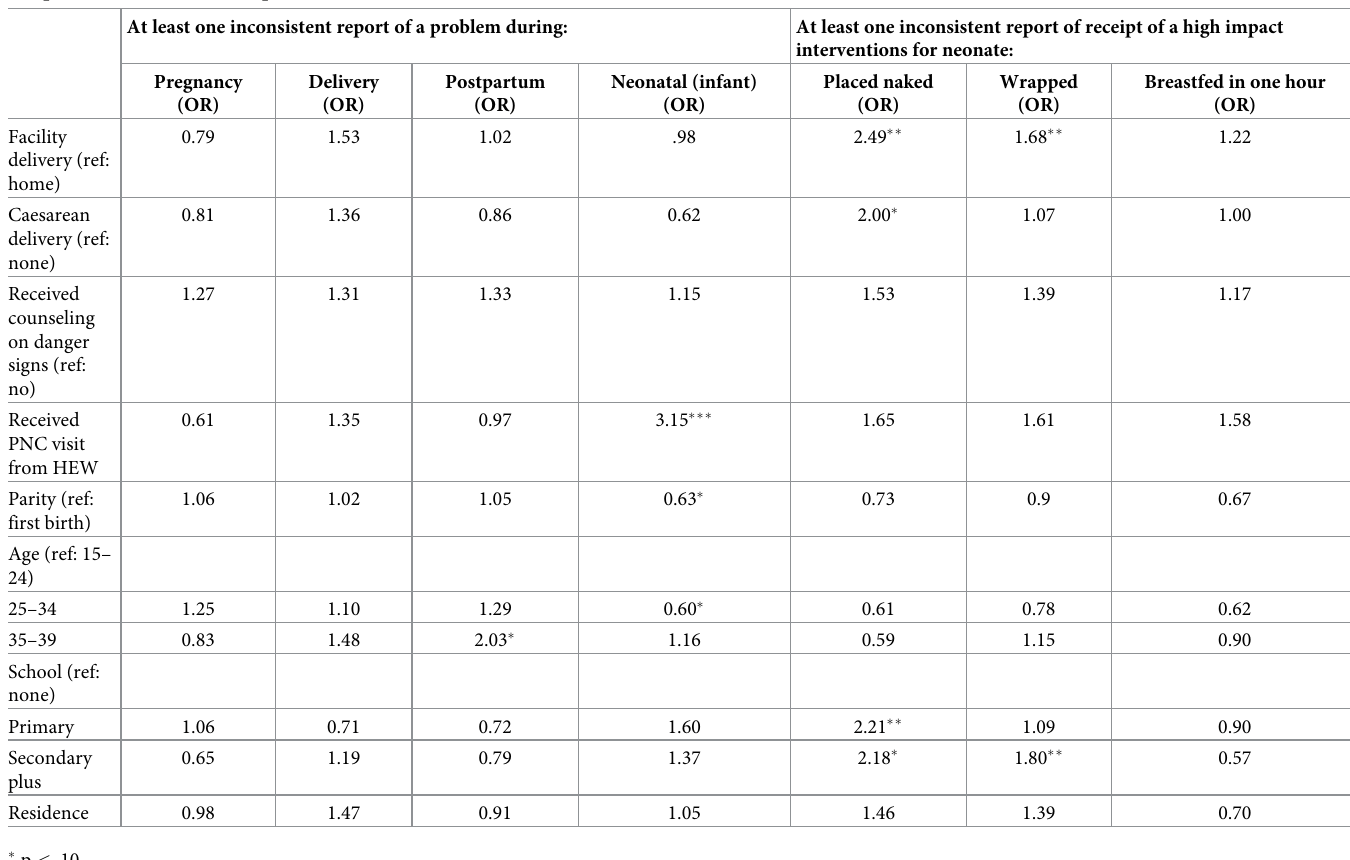
Table 8. Crude odds-ratio(OR) estimates from logistic regression models showing association of maternal characteristics and reporting discordant responses for complications/illness and receipt of interventions. At least one inconsistent report of a problem